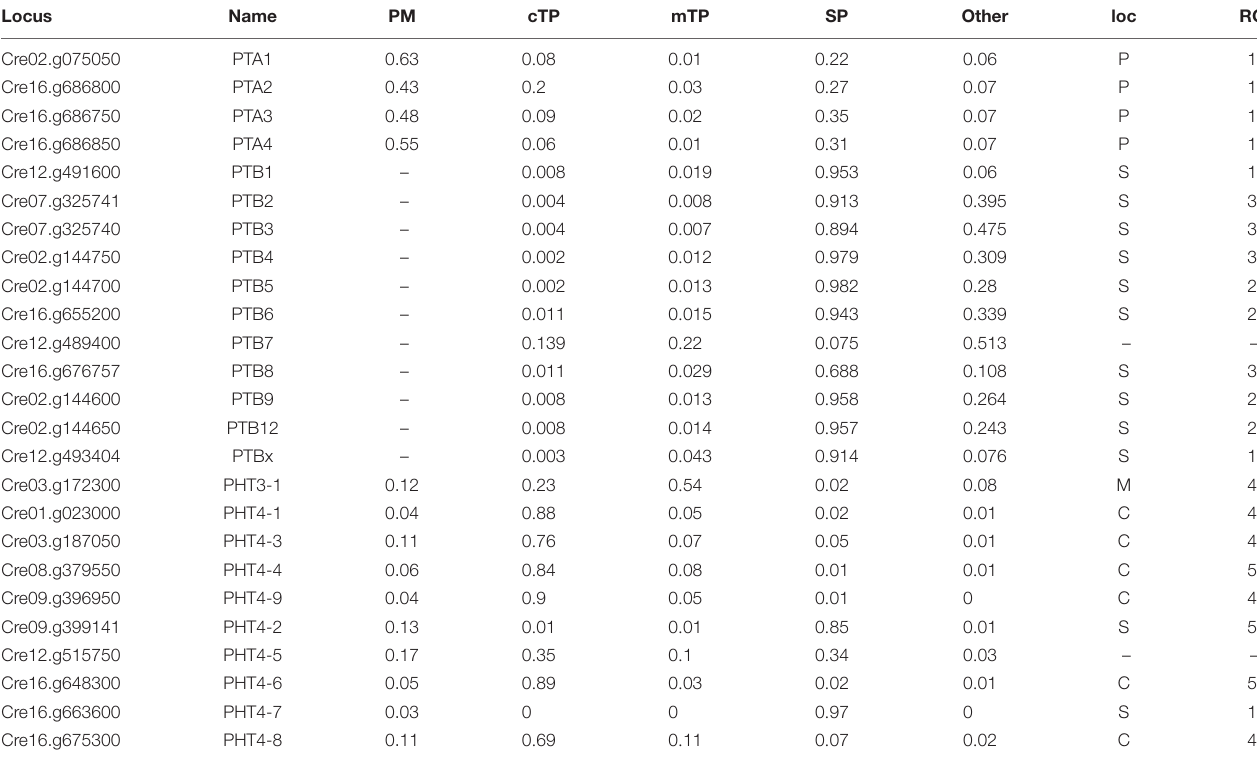
TABLE 2 | Prediction of subcellular targeting of PHT proteins in Chlamydomonas reinhardtii .